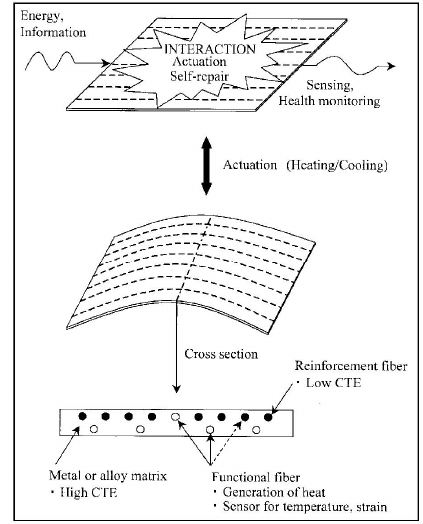
Figure 13. An active FRM embedded with functional fibers [57].